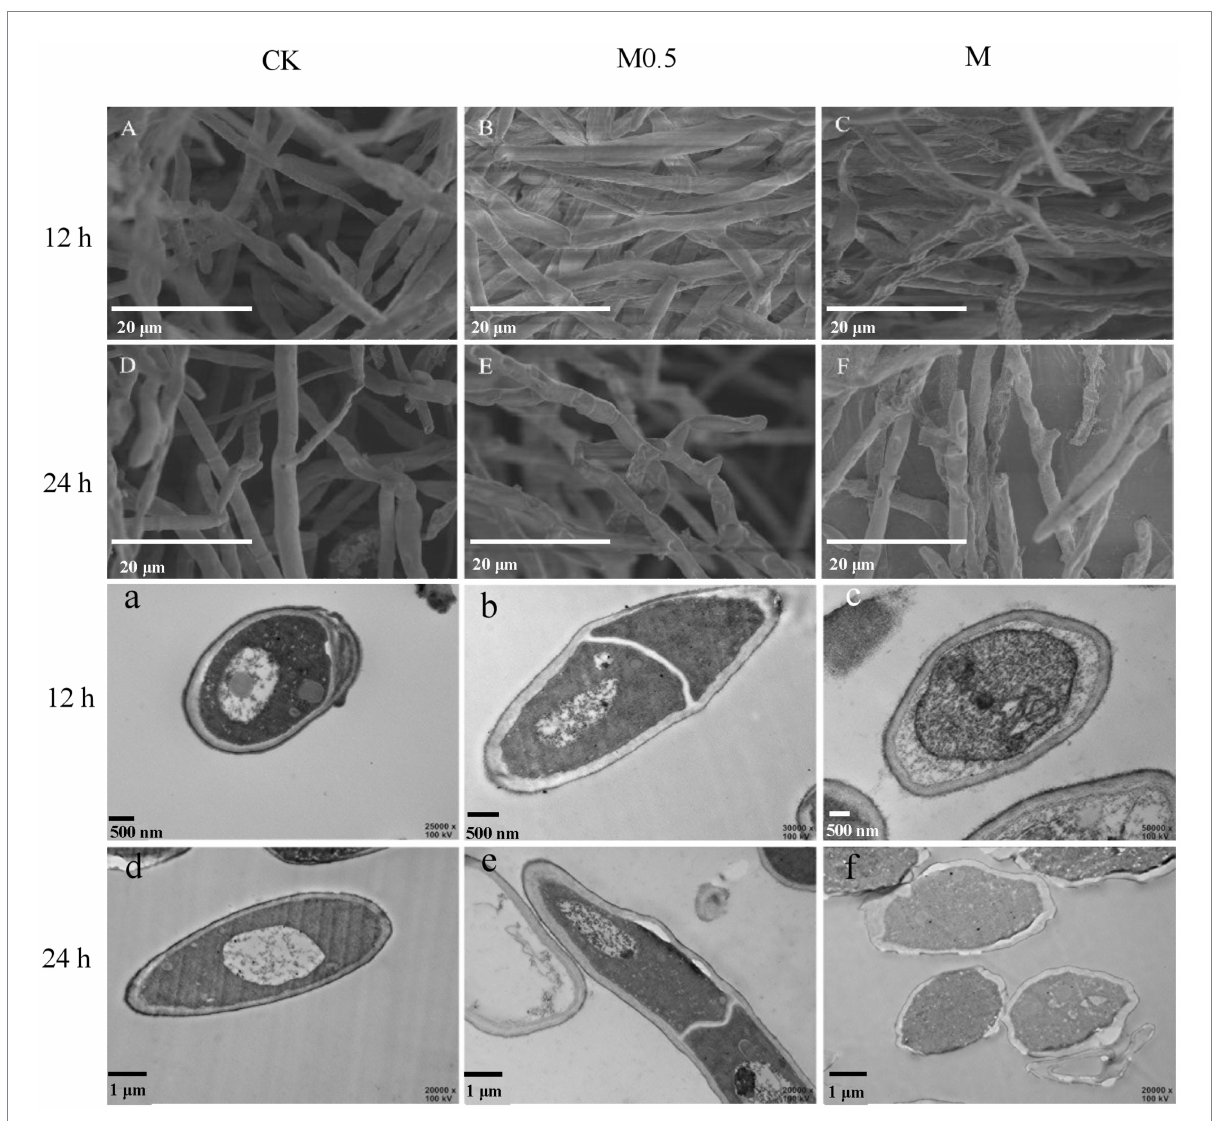
FIGURE 2 Scanning electron micrographs (A–F) and transmission electron microscopy (a–f) of F. oxysporum treated with different concentrations of A. officinarum Hance EO for 12 h and 24 h, respectively. ( A–C , a–c ): EO treatment for 12 h; ( D–F , d–f ): EO treatment for 24 h. All treatments were consistent with the